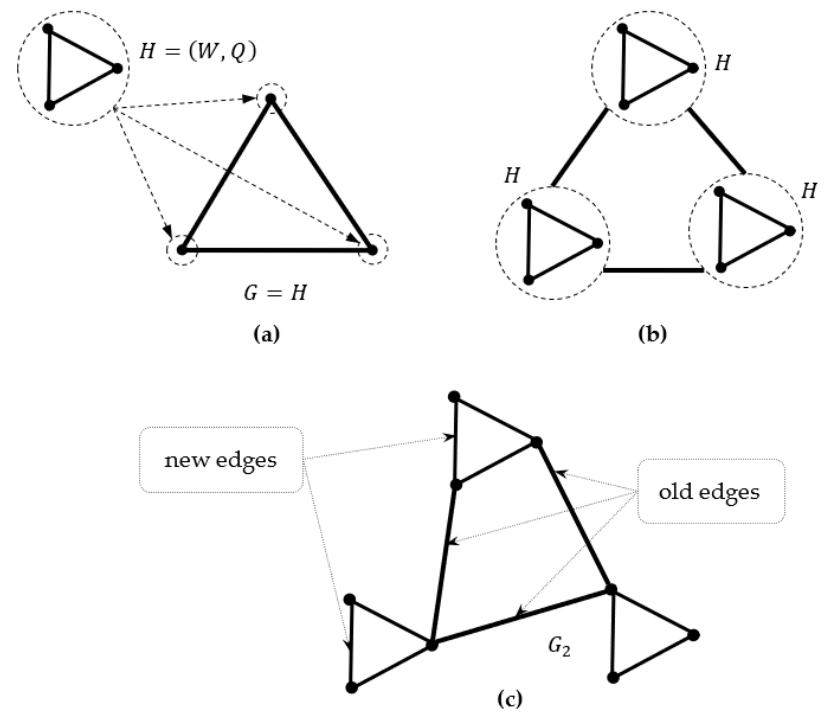
Figure 2. Operation of the replacement of vertices of graph G 1 by seed H . The essential characteristics of a prefractal graph G L = ( V L , E L ) are the number of its vertices (1) and edges (2). where n = | W | is the number of vertices of seed H